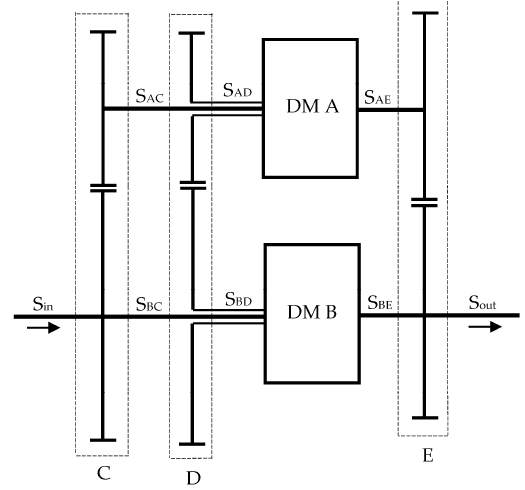
Figure 2. Fundamental architecture of the transmission.